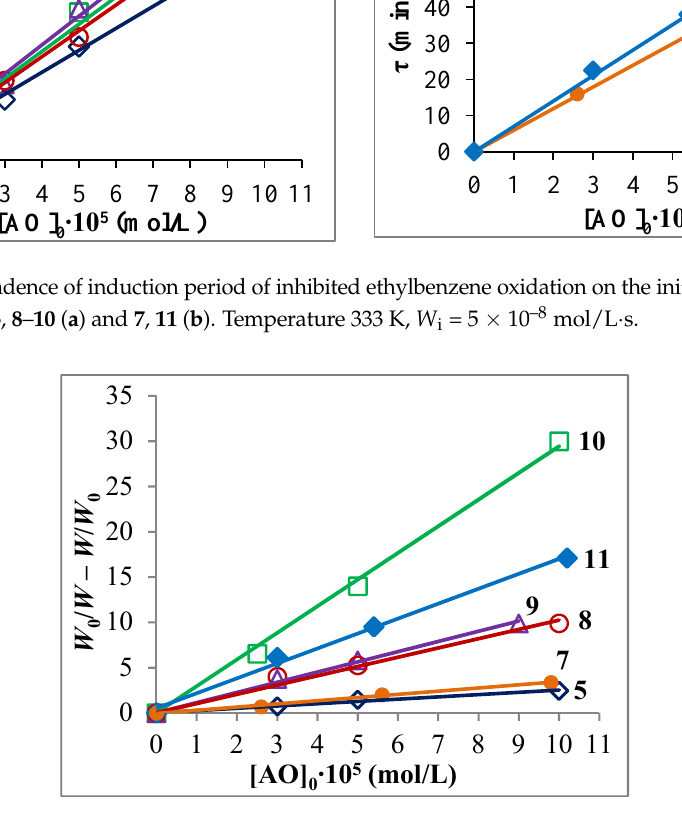
Figure 4. Dependence of the initial rate of inhibited ethylbenzene oxidation on the initial concentration of compounds 5 , 7 – 11 in the coordinates of the equation W 0 / W − W / W 0 = fk inh [AO] 0 / k r0.5 W i0.5 . Temperature 333 K, W i = 5 × 10 −8 mol/L·s. Table 1. The values of the stoichiometric coefficient f , the inhibition parameter fk inh , the rate constant of the reaction with the peroxy radicals ethylbenzene k inh (temperature 333 K).